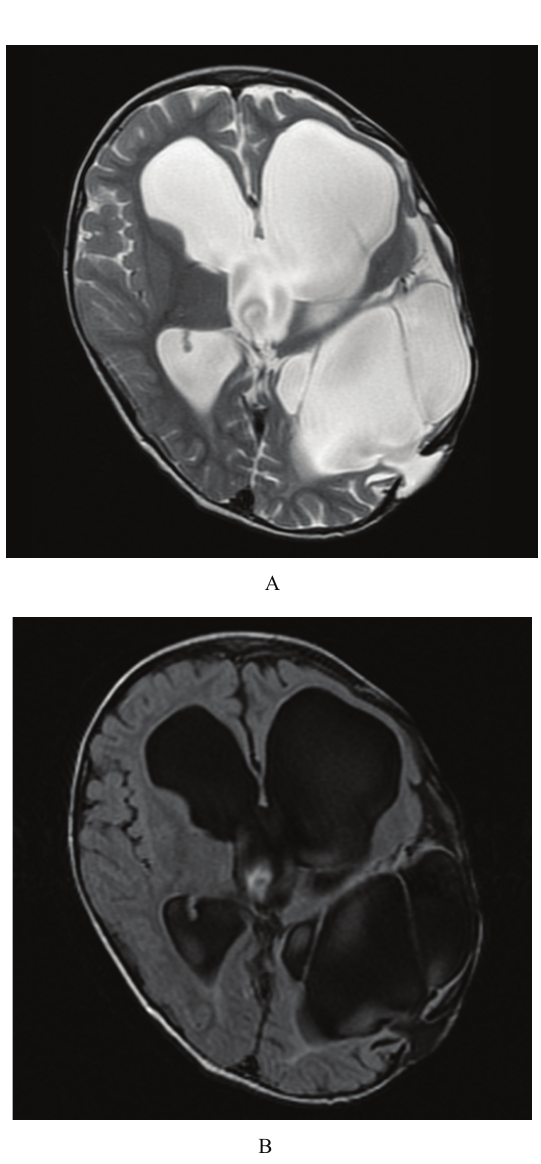
Figure 4 : Four-year follow-up brain MRI . (A) Axial T2-weight imaging and (B) FLAIR imaging demonstrating a big cystic lesion of left middle cranial fossa, diffuse severe dilation of third and lateral ventricles, and also a small subcutaneous fluid collection in left temporoparietal region with connection to left lateral ventricle, representative of postoperative changes and noncommunicating